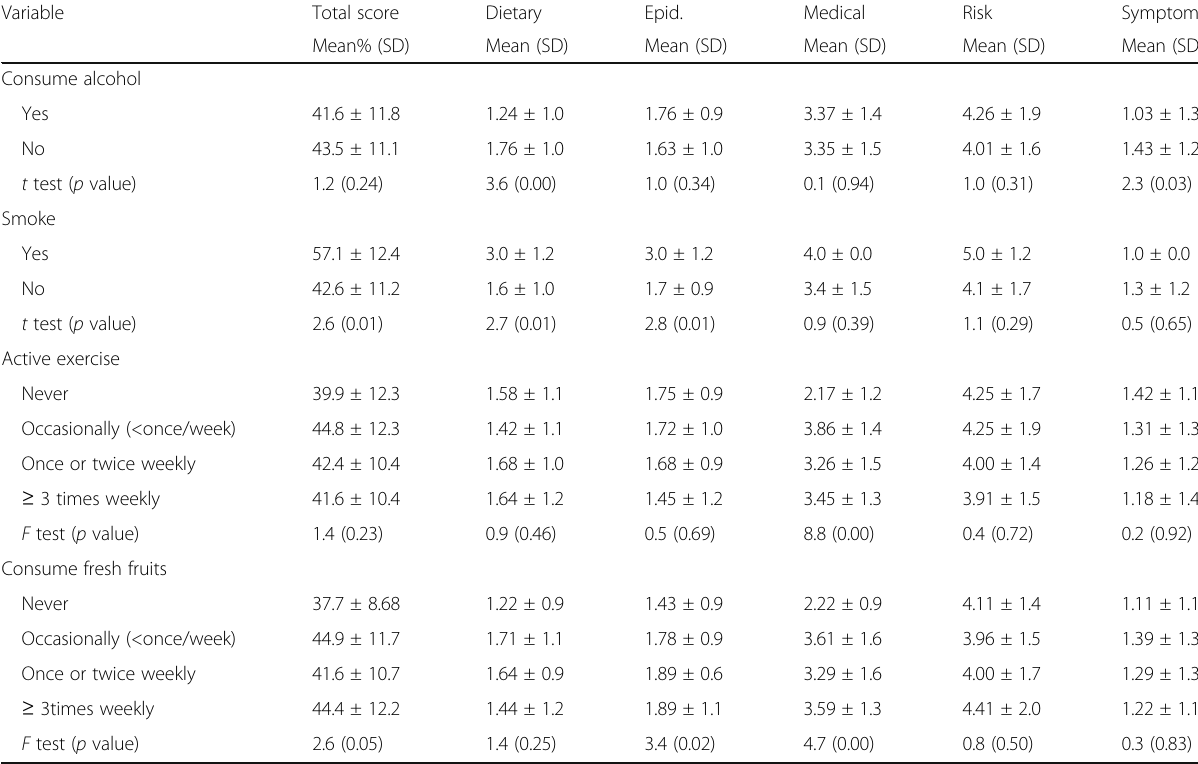
Table 6 Behavioral risk factors associated with knowledge of CVD ( N = 212)